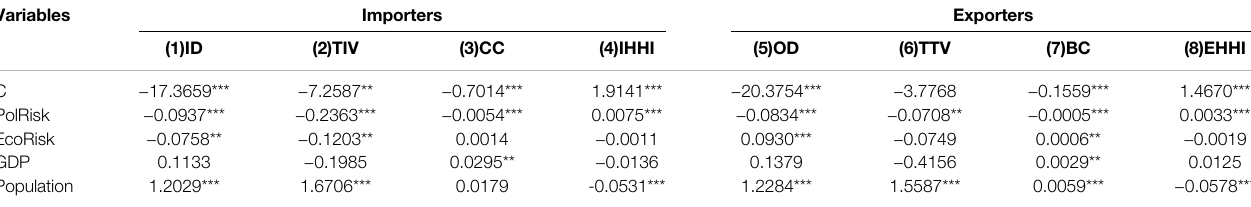
TABLE 3 | Panel regression results of the country risks to the dependence patterns of cobalt trade.